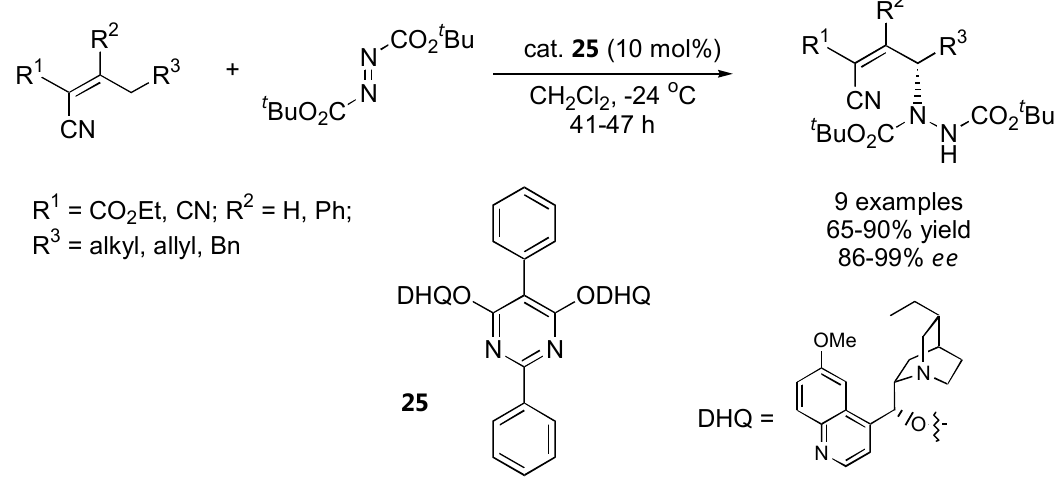
Figure 10. Direct allylic amination of alkylidene cyanoacetates catalyzed by 25